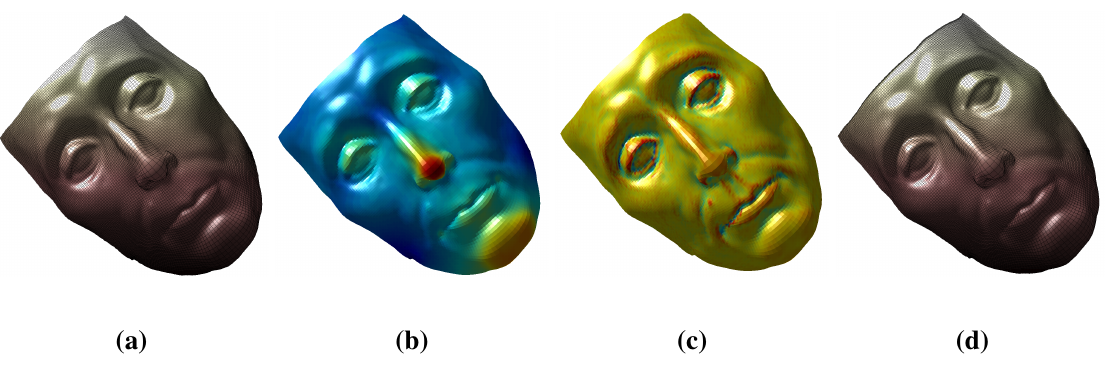
Figure 3. ( λ − H ) representation of a human brain. ( a ) The original mesh of a brain. By finding the conformal parameterization of the brain to a rectangular conformal